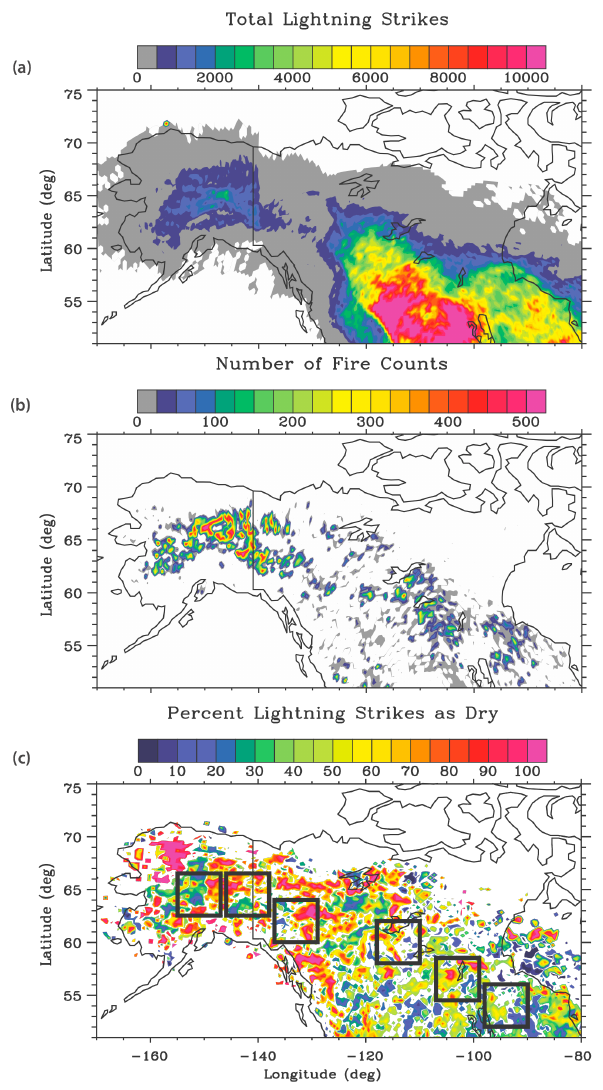
Fig. 3. (a) Total lightning strikes per grid box, (b) total fire counts per grid box, and (c) the percentage of lightning strikes occurring as dry strikes per grid box for the fire seasons of 2000–2006. The six boreal focus regions composing the western and eastern domains are displayed in black in (c) and are consistent with Fig. 1. White color indicates locations with no valid